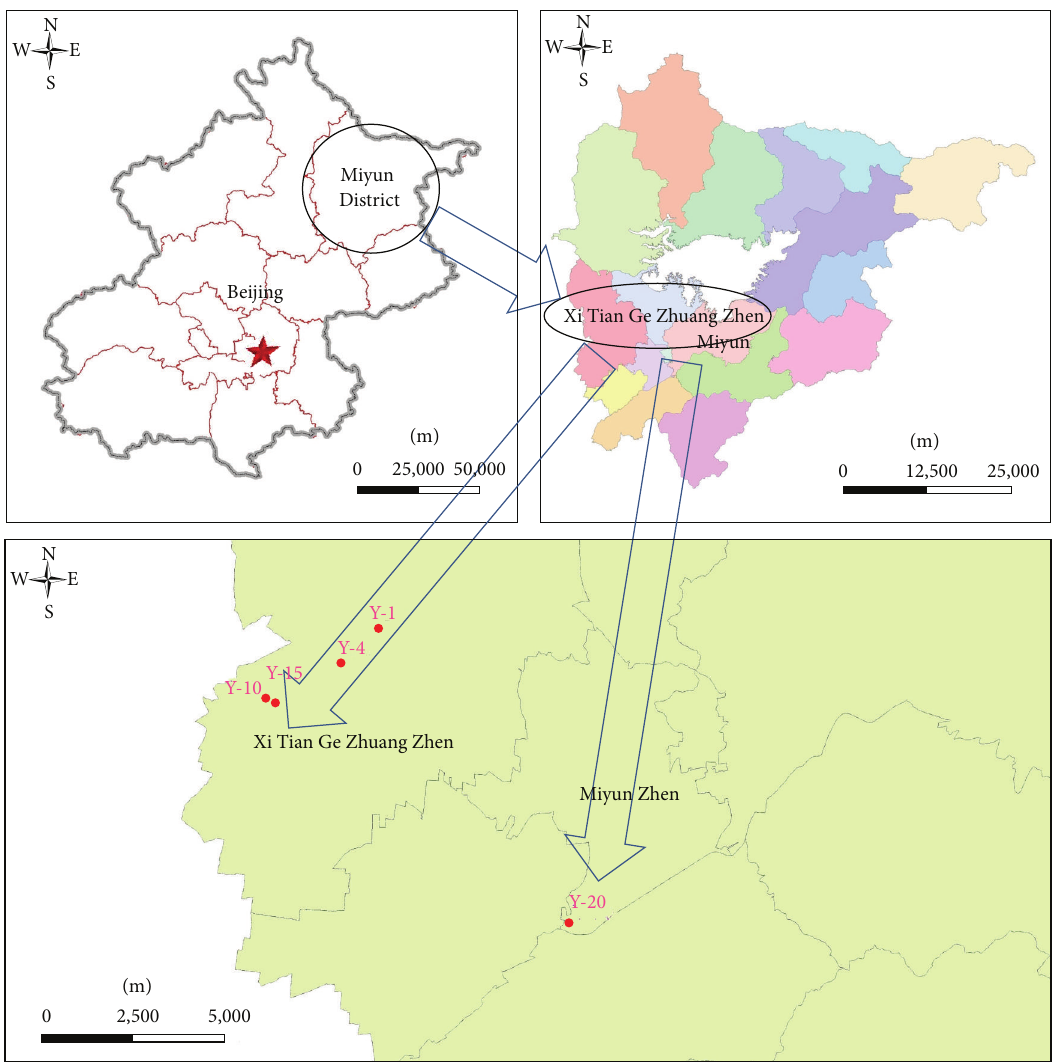
Figure 1: Schematic map of the selected area and the sampling